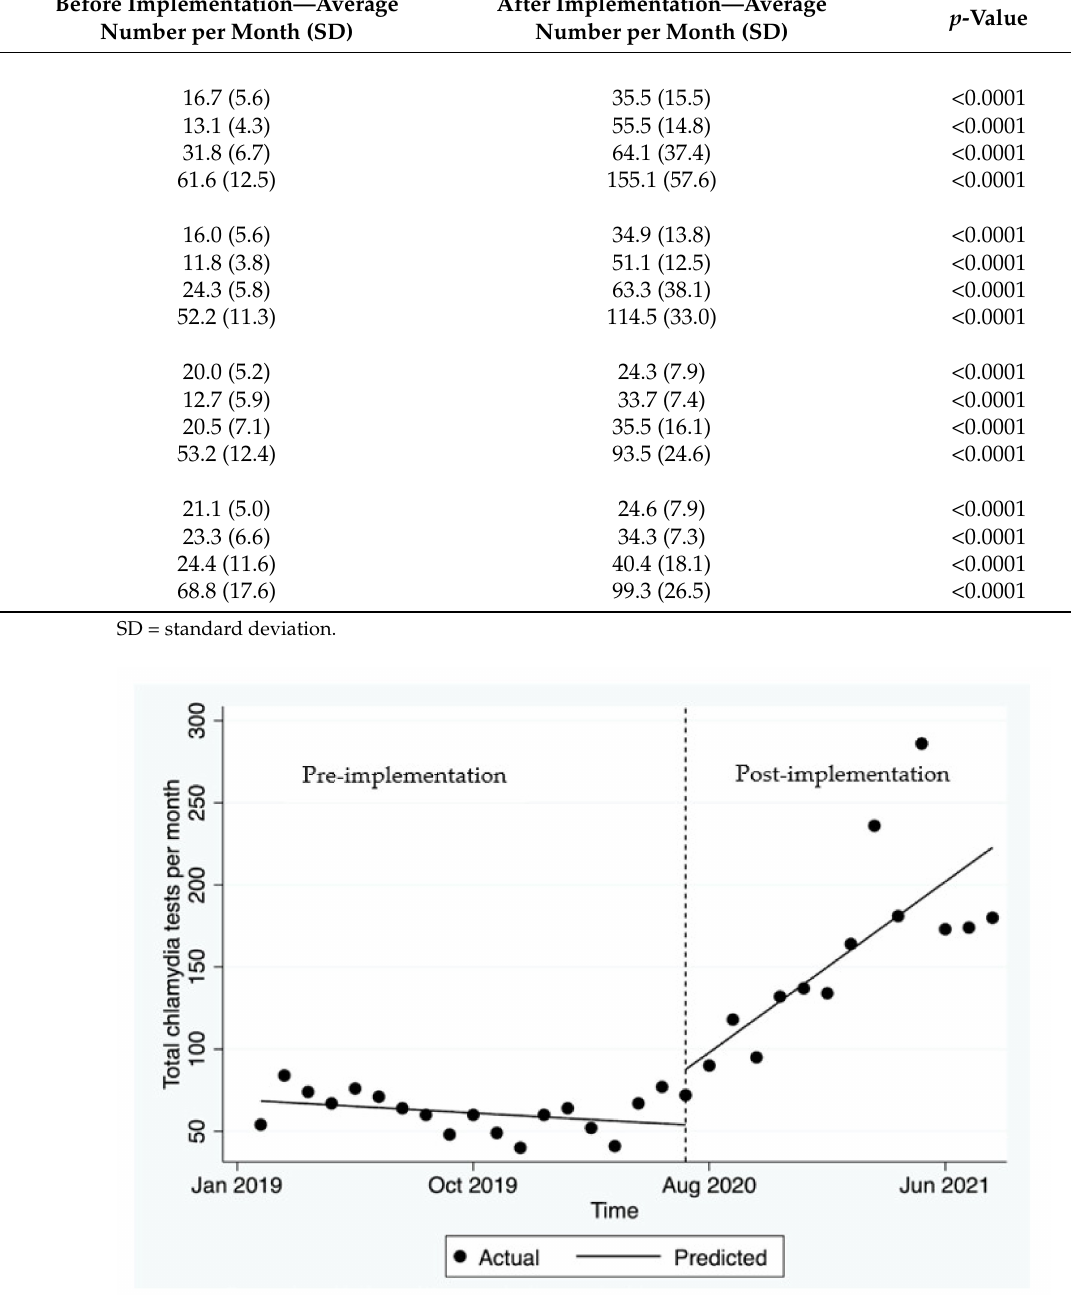
Figure 1. Number of tests for chlamydia before and after the hub-and-spoke model was